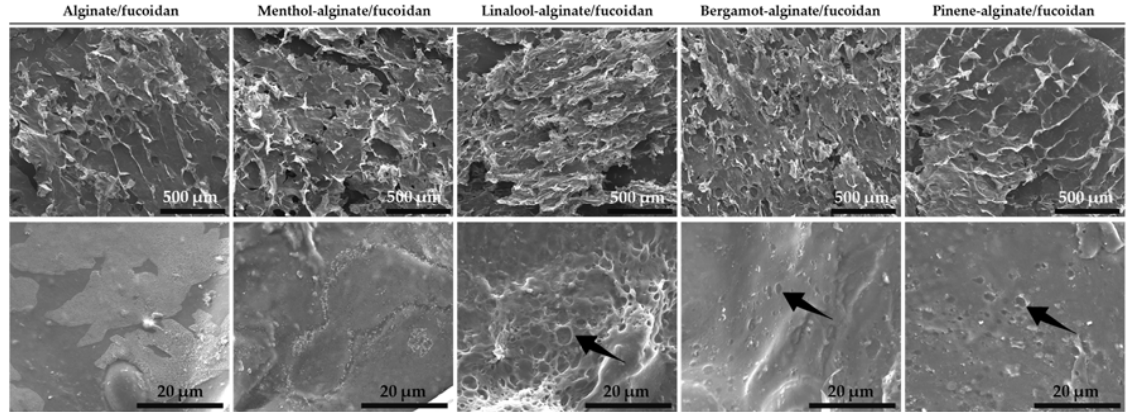
Figure 1. SEM micrographs of hydrogels (top scale bars: 500 µm; bottom scale bars: 20 µm).